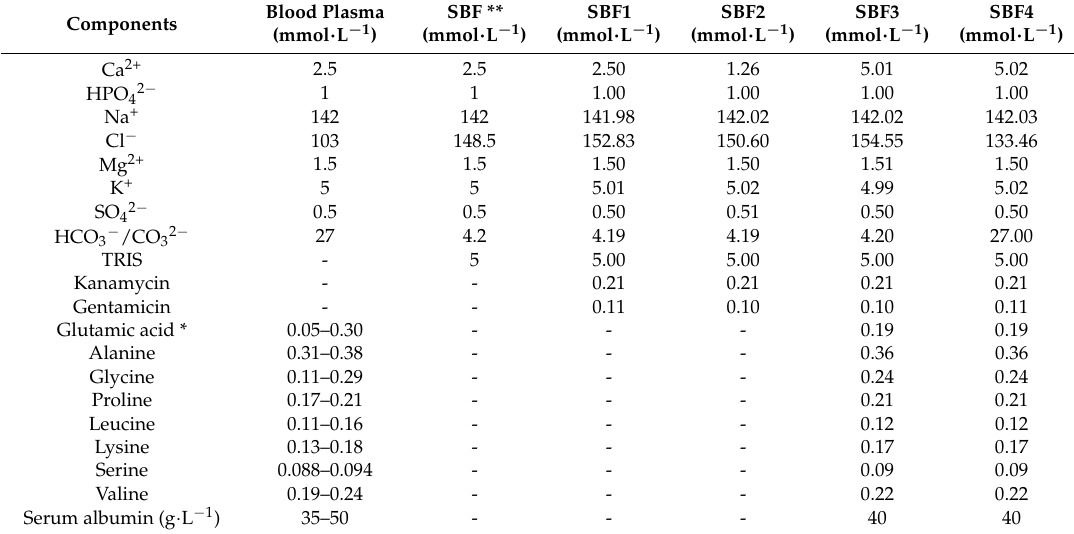
Table 2. Chemical compositions of the human blood plasma and applied simulated body fluids SBF1–SBF4.